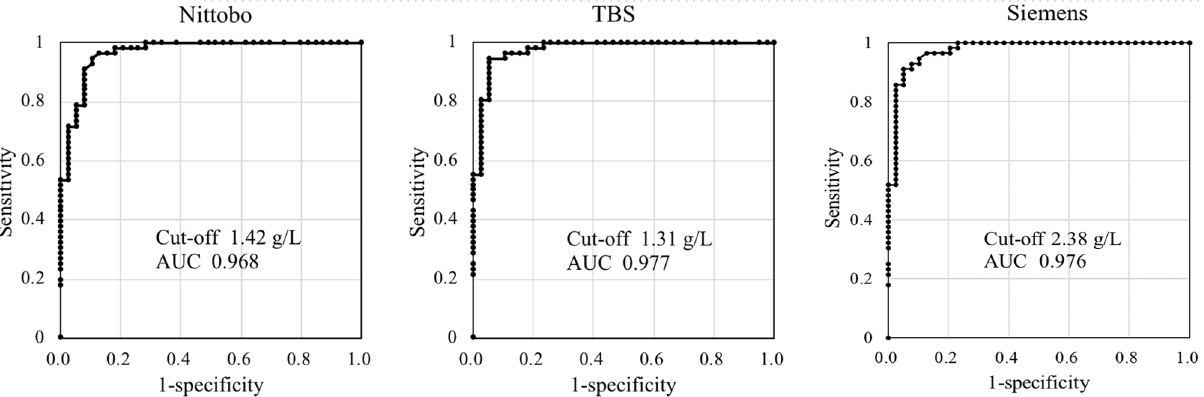
Figure 2. Receiver operating characteristic (ROC) curve analysis of IgG4 levels measured using the three reagents. The area under the ROC curve and cut-off value for each reagent were calculated using the data of the definite IgG4-RD group (n = 56) and untreated and diagnosed non-IgG4-RD patients from the non-IgG4-RD group (n =